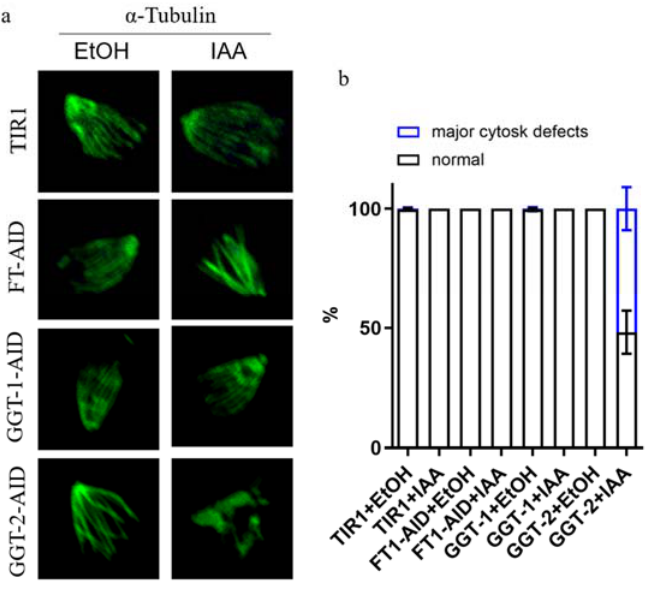
Figure 7. GGT-2 affects the subpellicular microtubules of parasites. ( a ) IFA was used to observe the effects of FT, GGT-1 and GGT-2 on subpellicular microtubules. The anti-rabbit tubulin and Alexa FluorTM 488 goat anti-rabbit were used as the primary and secondary antibodies, respectively. ( b ) The normal and abnormal morphology of microtubules in parasites was quantified, respectively, and at least 50 parasites’ subpellicular microtubules were analyzed. Scare bar: 10 µM.